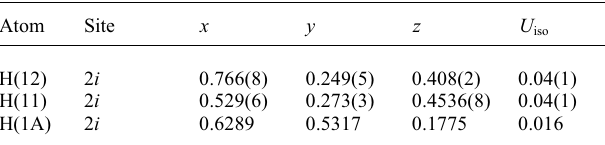
Table 2. Atomic coordinates and displacement parameters (in Å 2 ) .